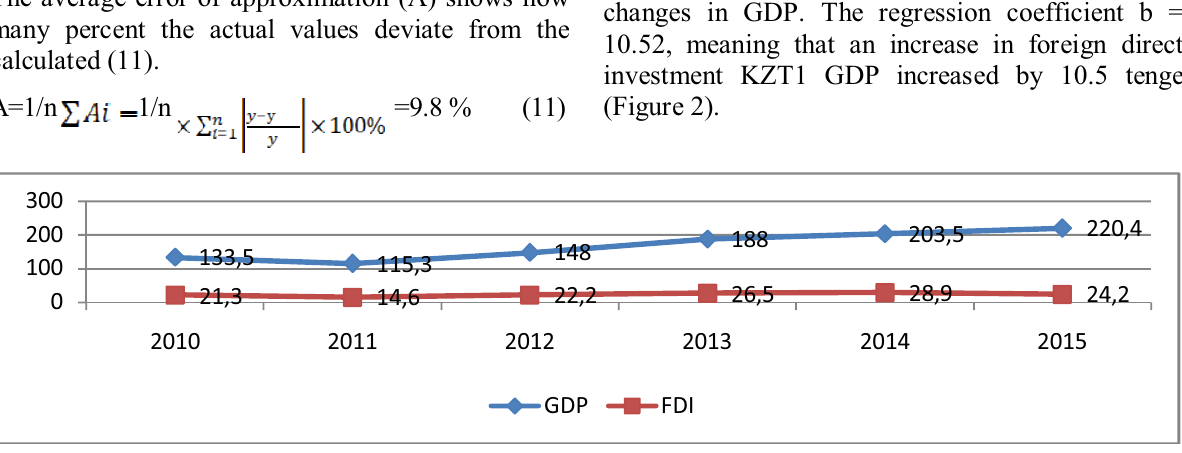
Fig. 2. Dynamics of GDP and FDI, mln. USD